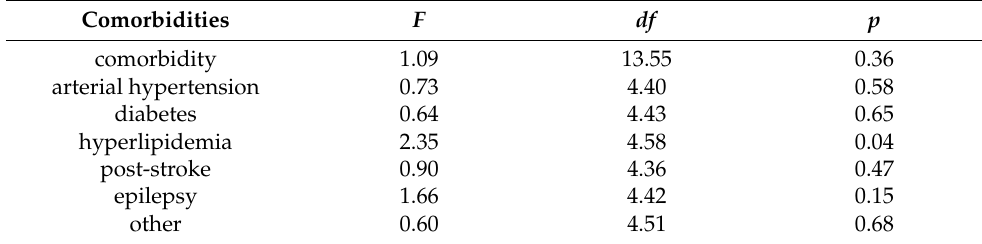
Table 2. The interaction effect of comorbidity on CADSS